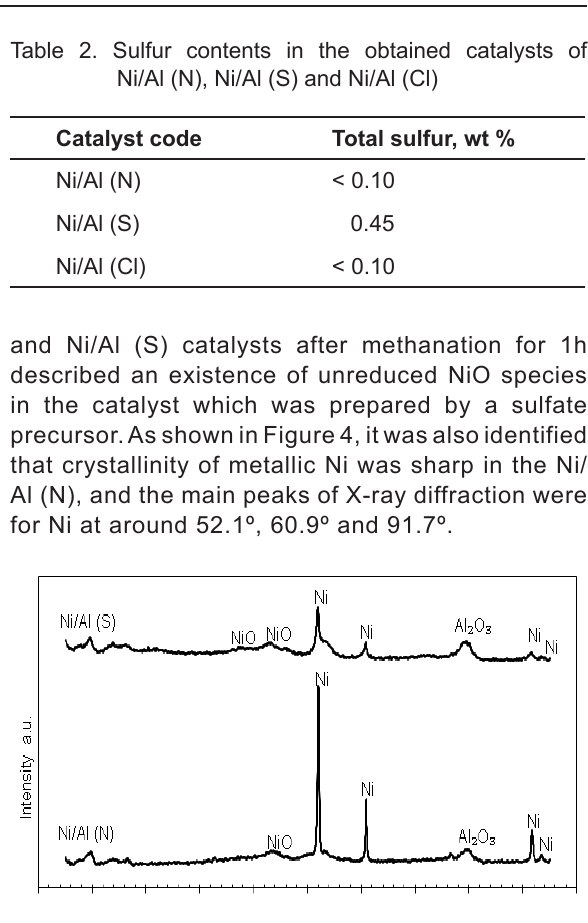
Fig. 4. X-ray diffractograms of the Ni/Al(N) and Ni/Al(S) catalysts after methanation for